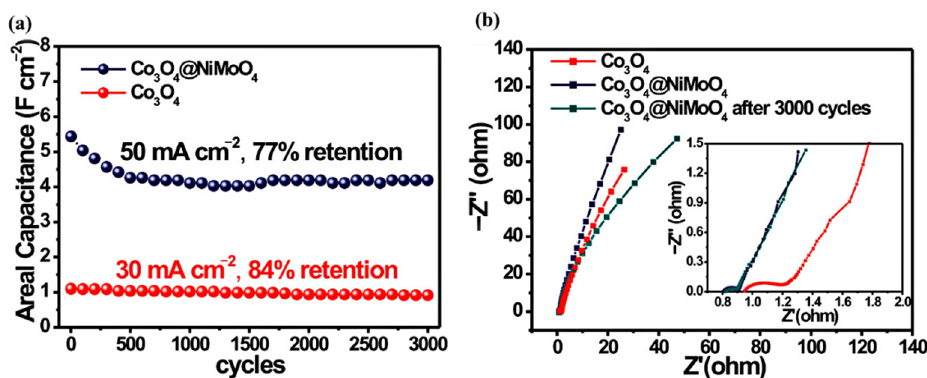
Figure 16. ( a ) Long-term cycling stability of the Co 3 O 4 and Co 3 O 4 @NiMoO 4 hybrid electrodes. ( b ) Impedance Nyquist plots of the Co 3 O 4 electrode and the Co 3 O 4 @NiMoO 4 hybrid electrode before and after 3000 cycles. Reproduced with permission from Daoping Cai, Three-Dimensional Co 3 O 4 @NiMoO 4 Core/Shell Nanowire Arrays on Ni Foam for Electrochemical Energy Storage; published by ACS Publications, 2014 [179].